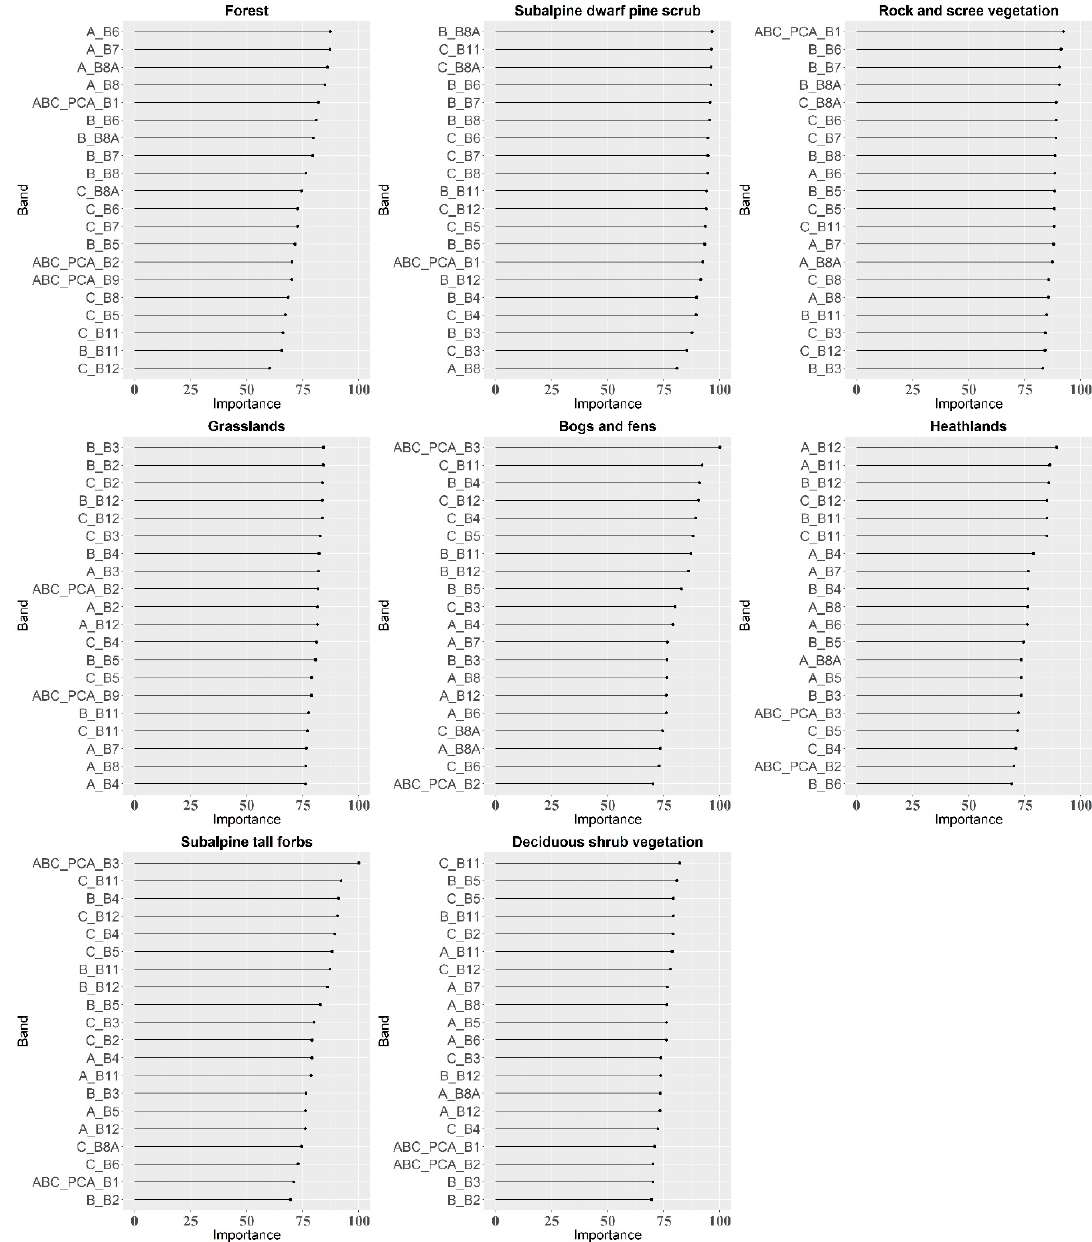
Figure A3. The 20 most important variables in classification of each vegetation type using ABC_PCA dataset.